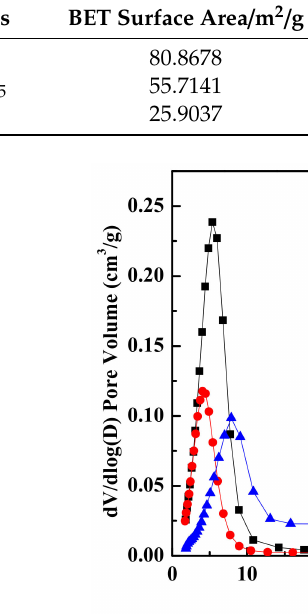
Figure 1. The pore diameter distribution of the catalysts.